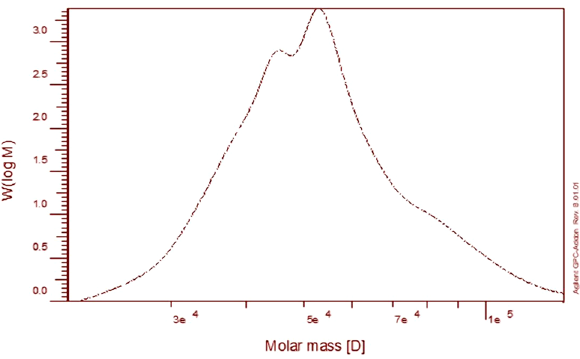
Figure 1. The molecular weight distribution of PsPc-3 from Pleurotus columbinus.